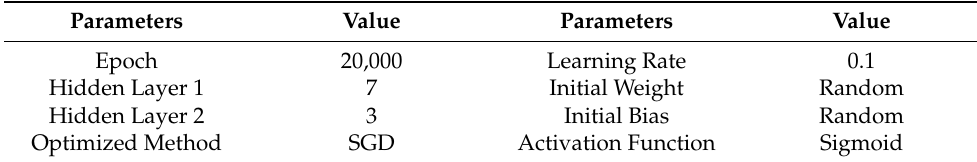
Figure 9. Optimal network architecture (CAE-243). Table 3. Network hyperparameter settings